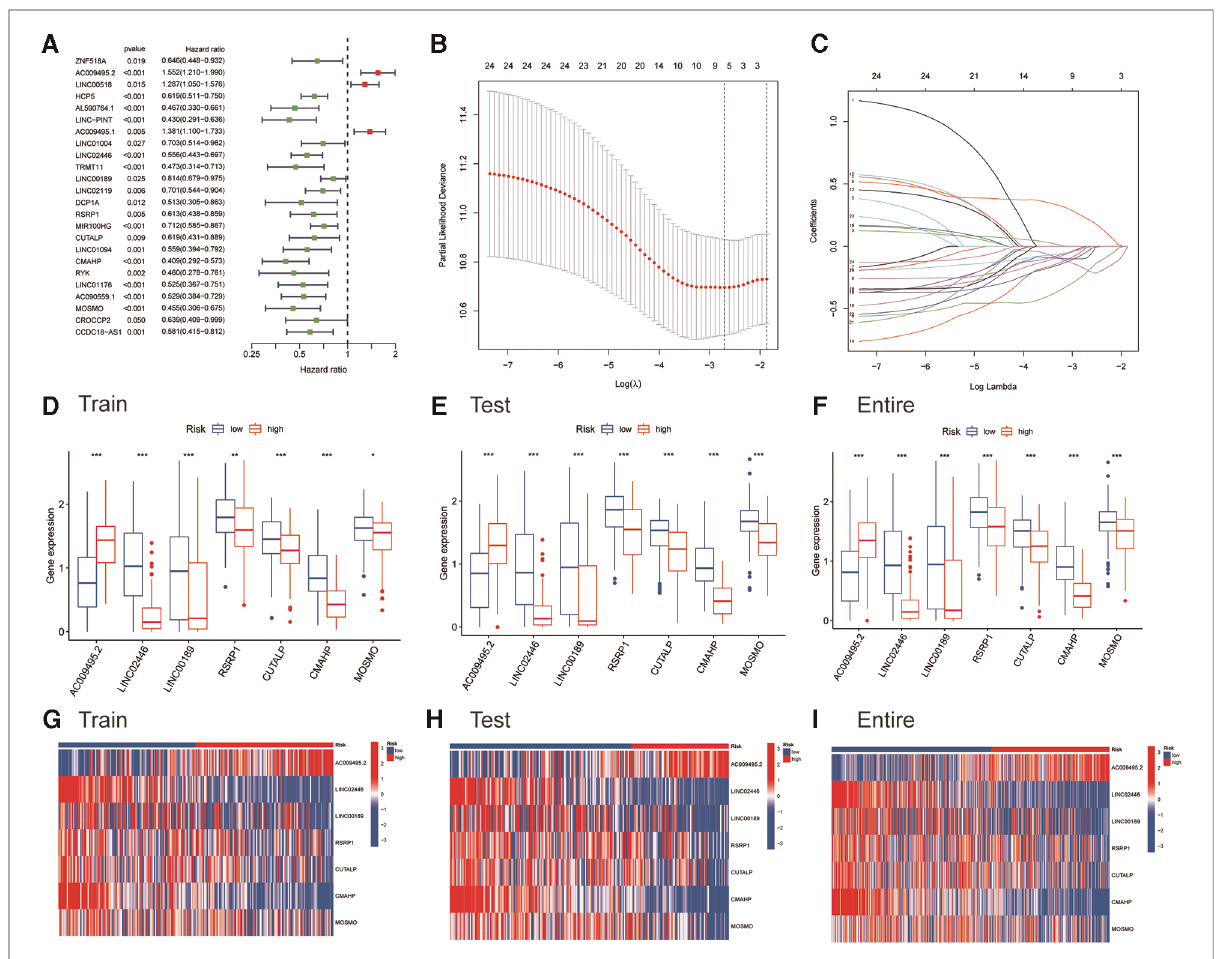
FIGURE 2 Identifying immune-related eRNAs (ireRNAs) associated with melanoma prognosis for construction of a signature. ( A ) Forest plots for hazard ratios of overall survival-related ireRNAs. ( B ) LASSO Cox analysis revealed 7 ireRNAs strongly correlated with the prognosis of melanoma. ( C ) The model ’ s penalty parameter ( λ ) was determined by 10-round cross-validation. ( D – F ) Differentially expressed analyses for ireRNAs between high- and low- risk groups in the training, testing, and entire cohorts, respectively. ( G – I ) Heatmap for ireRNAs involved in the signatures of the training, testing, and entire cohorts,